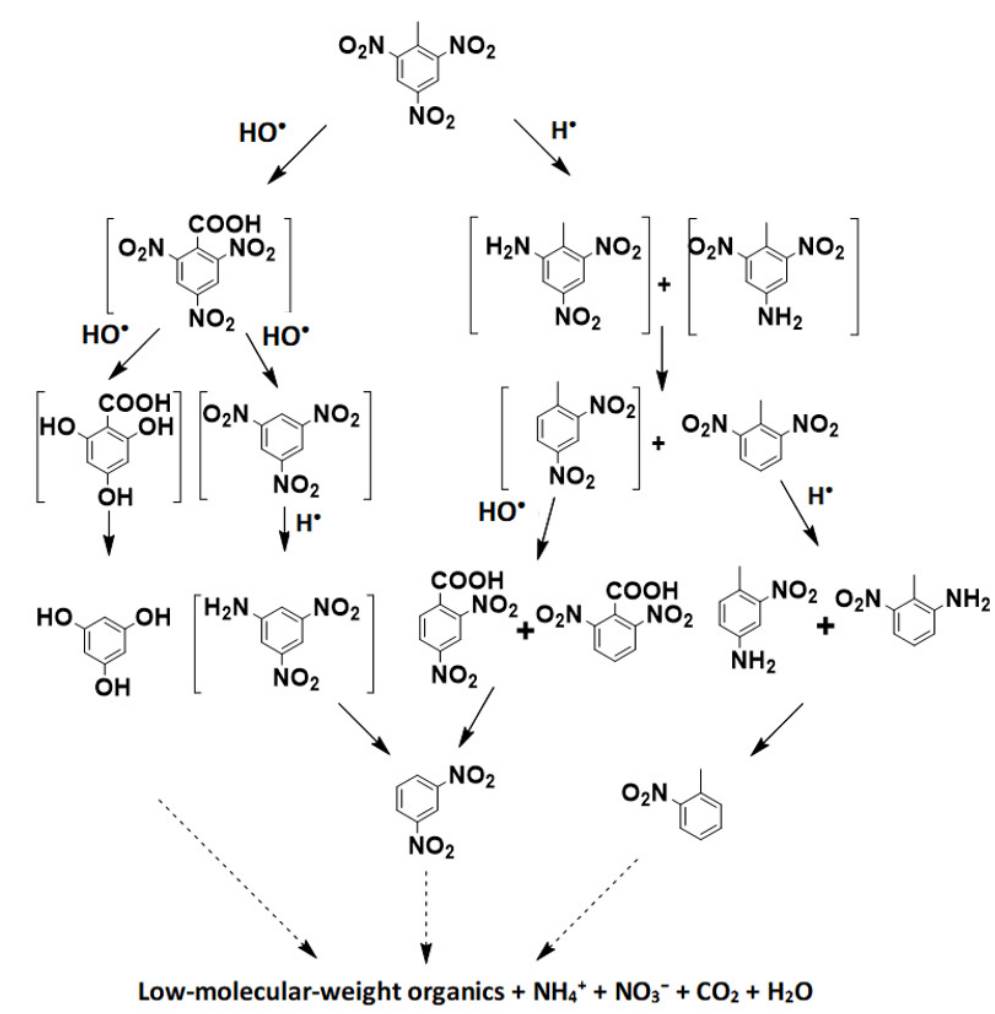
Figure 8. Degradation pathway of TNT by US–Fenton treatment. Organic compounds in square brackets were intermediates identified by GC/MS in this study.